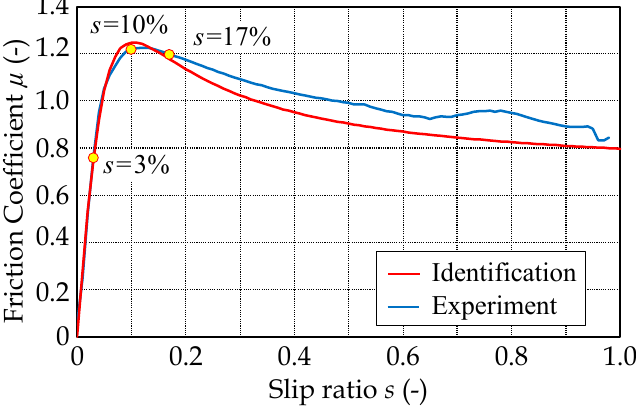
Figure 2. An example of estimated result using MF.